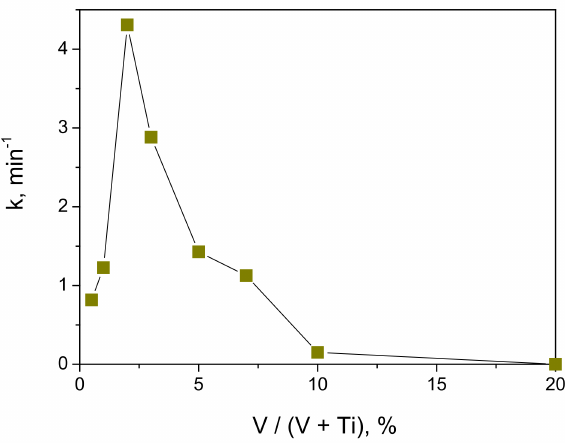
Figure 8. Photocatalytic measurements with UVA lamp “on” using V-TiO 2 coated glass beads (GB). Vanadium content (in mol%) is indicated.